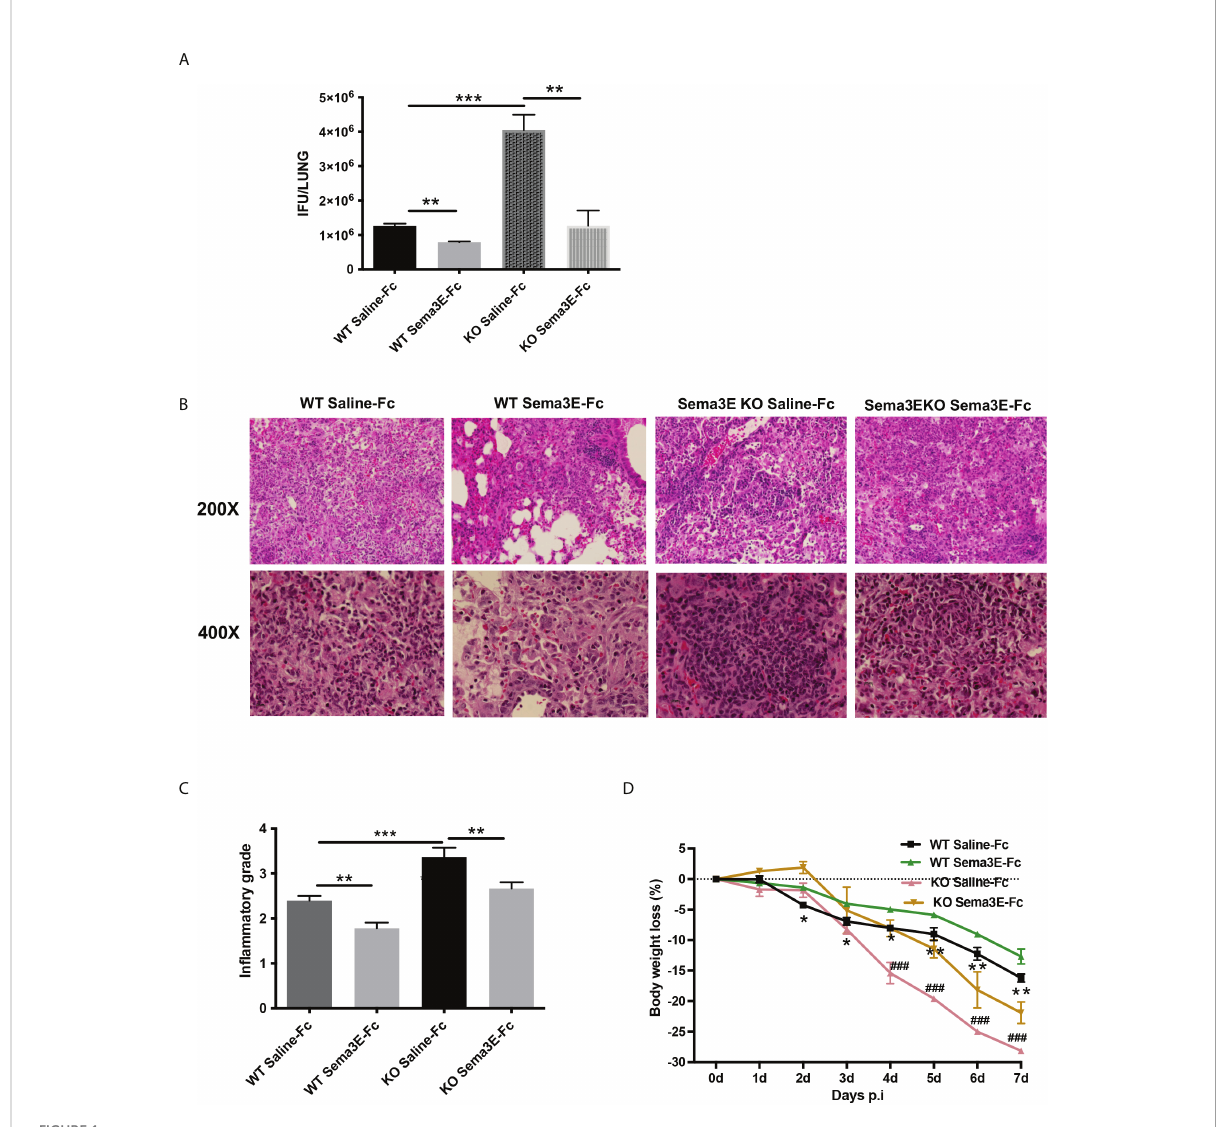
FIGURE 1 Semaphorin 3E treatment enhances the ability to control C. muridarum lung infection. Mice groups were treated with recombinant Sema3E-Fc intranasally 2 hours before Cm infection and day 1 to day 6 after infection. Mice were sacri fi ced at day 7 post-infection. (A) Chlamydial growth in vivo after Sema3E-Fc or saline-Fc treatment of WT and Sema3E KO mice. (B) The pulmonary pathology. Lungs from Sema3E-Fc or saline- treated mice were sectioned, and the lung pathology was examined by H&E staining and analyzed in (×200 and ×400x) magni fi cation under light microscopy. (C) Lung in fl ammation was analyzed semi-quantitatively by a blinded pathologist as detailed in Materials and Methods. (D) Mice were monitored daily for body weight changes. After chlamydial infection, lower body weight loss was observed in Sema3E-Fc treated WT mice and Sema3E KO mice. Each point represents the mean ± SD of three mice. One representative experiment of three independent experiments with similar results is shown. Signi fi cant differences in the bodyweight loss of Sema3E-Fc treated and saline-Fc treated WT mice are shown as asterisks (*), differences in the bodyweight loss of saline-Fc treated WT mice and saline-Fc treated Sema3E KO mice are shown as hashtags (#). * p < 0.05, ** p < 0.01, ***p < 0.001, ### p <